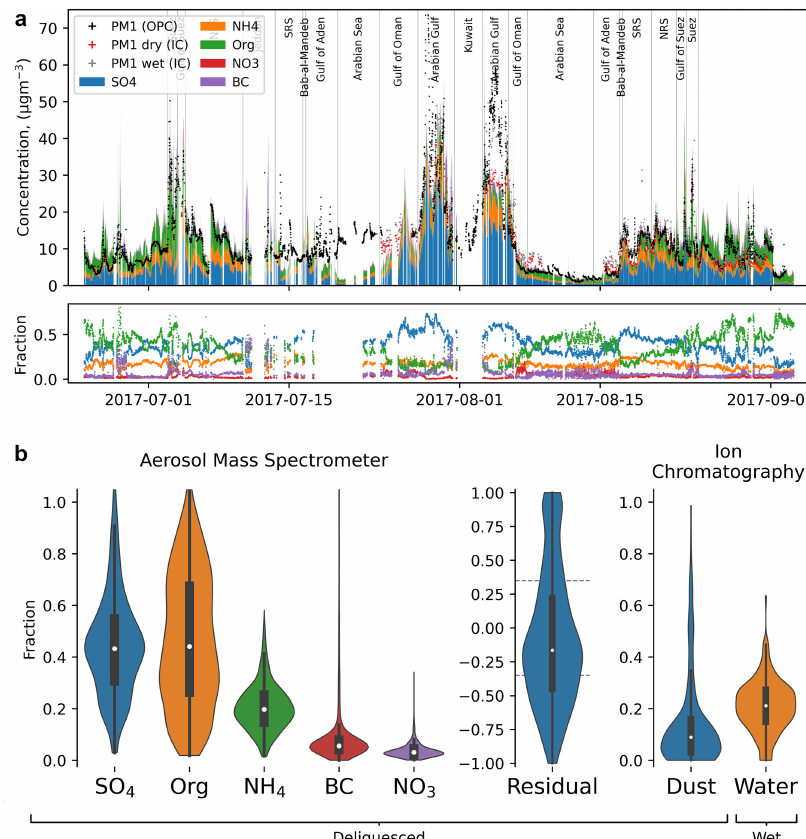
Fig. 3 Fine aerosol composition during the AQABA campaign. a The stacked area plot shows the fi ve major components (sulfate SO 4 2- , ammonium NH 4 + , total organics Org, nitrate NO 3 − , black carbon BC) of the deliquesced (40% RH) particles measured by the aerosol mass spectrometer (AMS) and aethalometer. Black dots indicate the total nonspeciated aerosol obtained by integrating the size distribution (OPC). Red and gray dots indicate the speciated aerosol measured by ion chromatography (IC). These measurements include the contributions from dust and sea salt, but not ammonium. Red dots indicate the sum of the dry particle components. Gray dots include the aerosol water, calculated with an aerosol thermodynamics model 35 . b Violin plots show the summary statistics, with the median, interquartile range and kernel density of the speciated fi ne PM fractions relative to the total nonspeciated fi ne PM, with a residual of